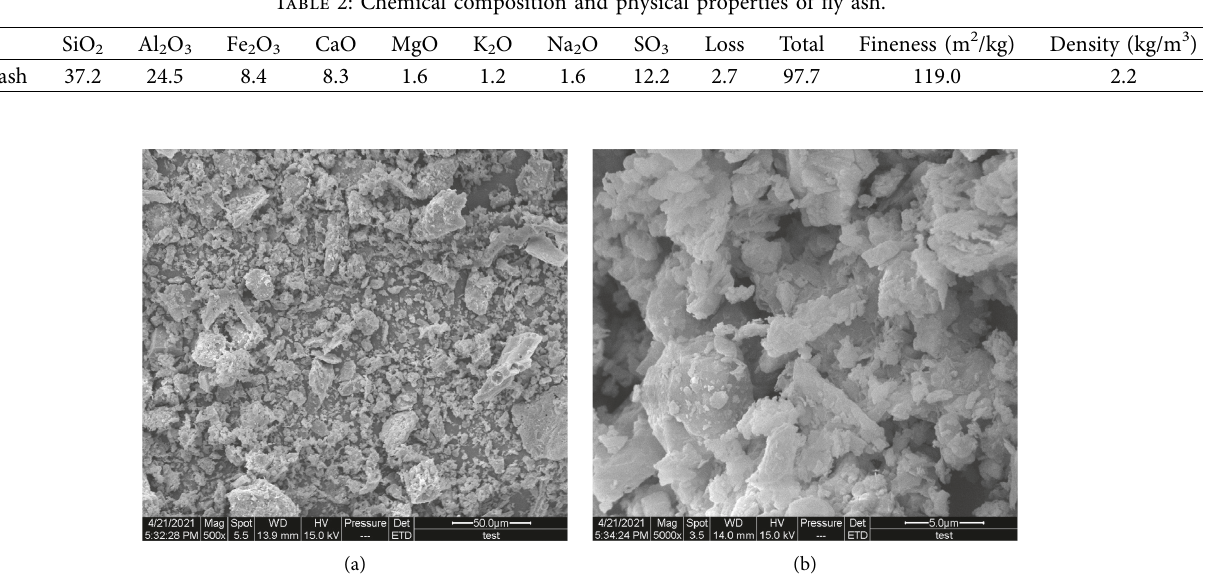
Figure 3: SEM photos of fly ash. (a) 500 times of SEM photo. (b) 5000 times of SEM photo.